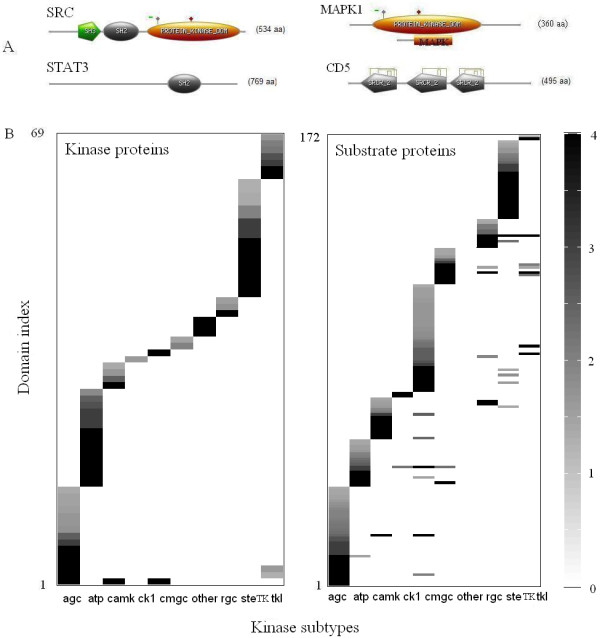
Protein domains enriched in kinase- and substrate subtypes. Example of protein domains annotated on the amino acid sequences of kinases and their substrates using PROSITE web tool screen shot (A), their statistical enrichment among kinase and substrate subtypes (B). The horizontal axis in B identifies the kinase (substrate) subtype (agc, atp, camk, ck1, cmgc, other, rgc, ste, TK, tkl) in the notation [2]. The vertical axes on the left refer to the identity index of statistically enriched domains in these subgroups of proteins (see Additional File 1 for key to the index). The scale on the right shows the - log p value of statistical enrichment of domains in these protein subgroups.